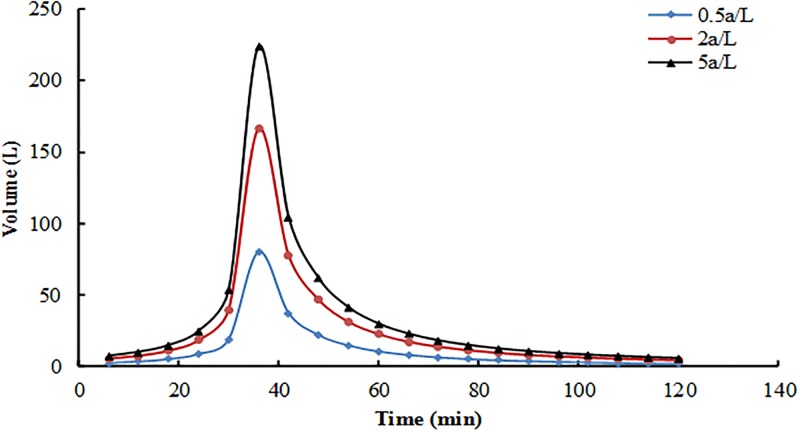
Rainfall pattern.